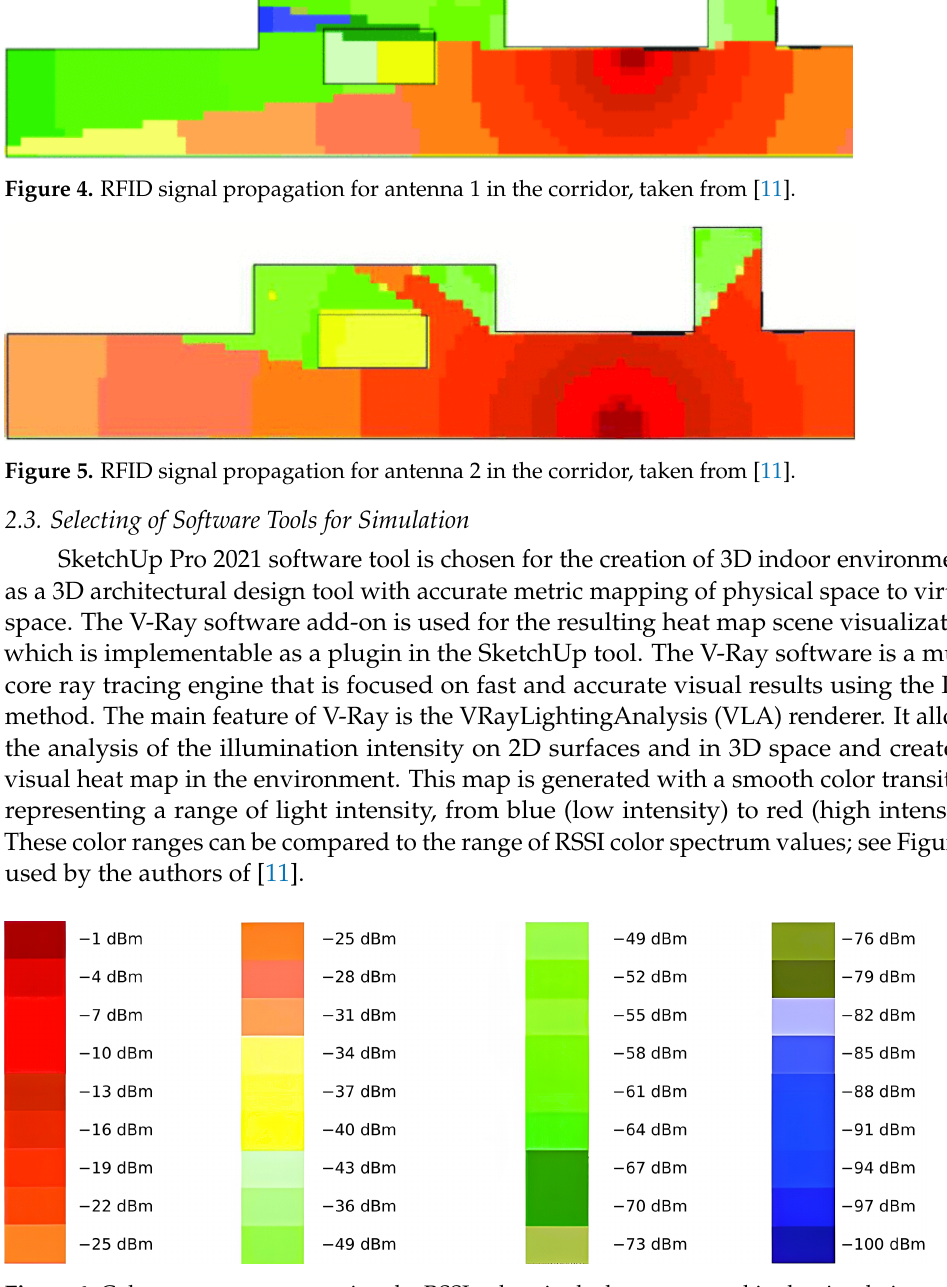
Figure 6. Color spectrum representing the RSSI values in the heat map used in the simulation, taken from